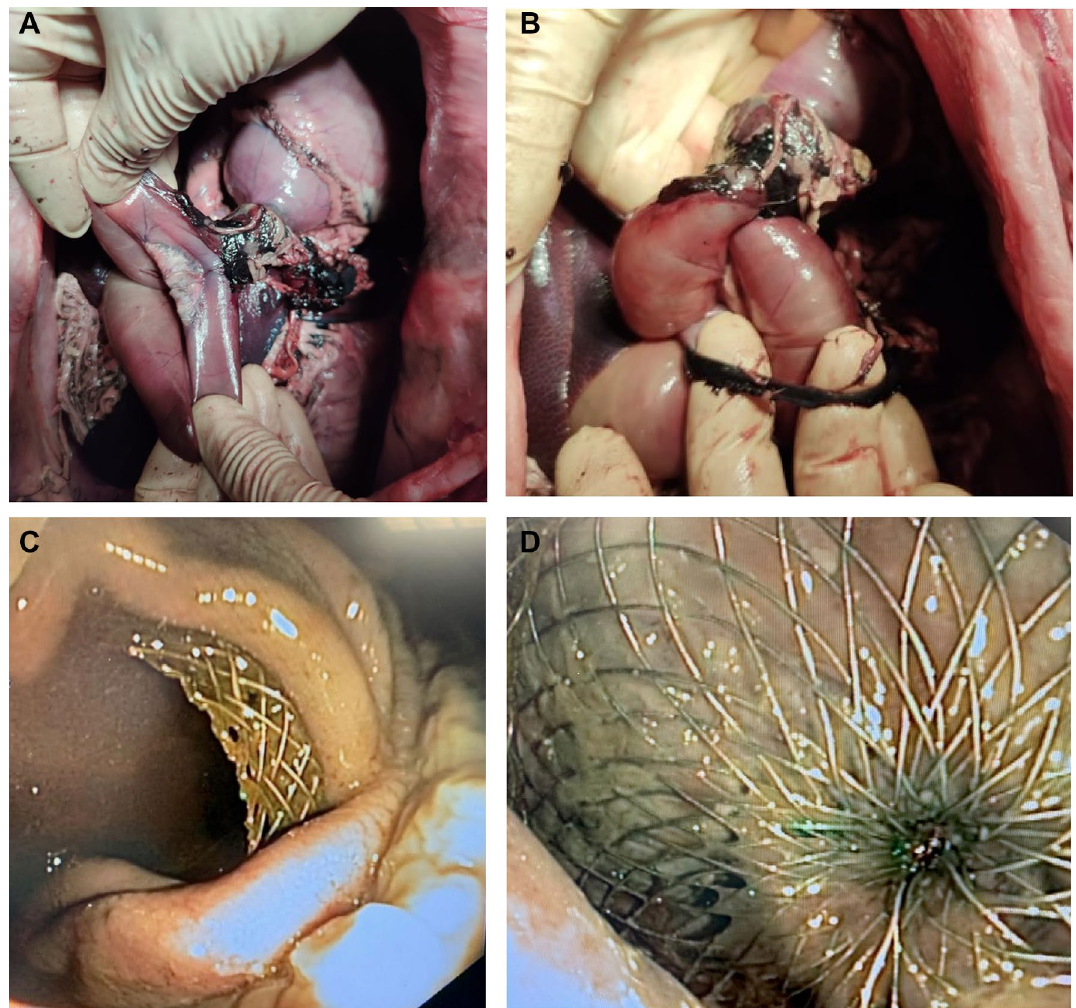
Figure 4. Necropsy specimens from two pigs that died. Pig Blue died 9 days after GJ-LAMS placement. Necropsy revealed the ribbon-like splenic vein strangulating the efferent limb just below the GJA, leading to intestinal obstruction ( A , B ). Pig Purple died from an unknown cause on Day 29 (15 days after DED placement). GJA was in place with normal patency ( C ). DED was in place with partial tissue ingrowth ( D